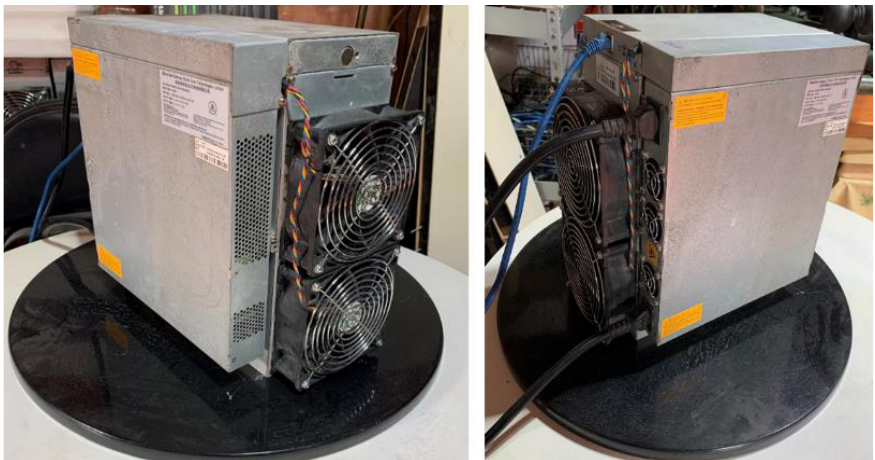
Figure 2. An operating Antminer S17e manufactured by Bitmain. Heat exhaust fans are displayed on the left image with a front-facing view. Cool air intake and power cables are displayed on the right with a rear-facing view.